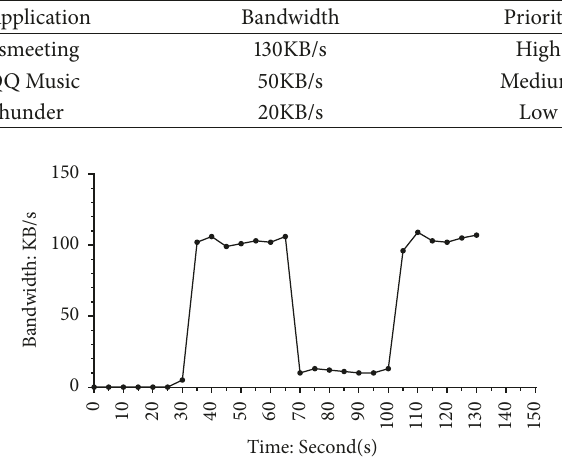
Figure 4: Download bandwidth control.